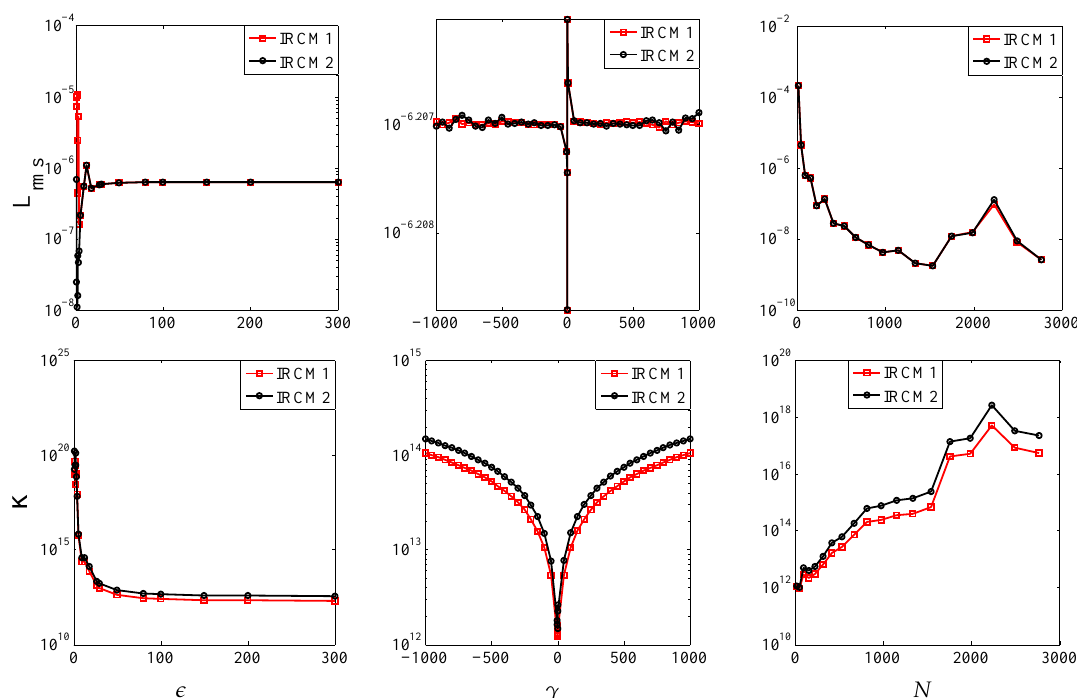
Figure 2. Test Problem 1, accuracy and κ versus (cid:101) , γ m, and N : ˆ Γ 1 = 60, ˆ Γ 2 = 16, γ = 1, (cid:101) = 80, and N = 94 when its influence is interestless.